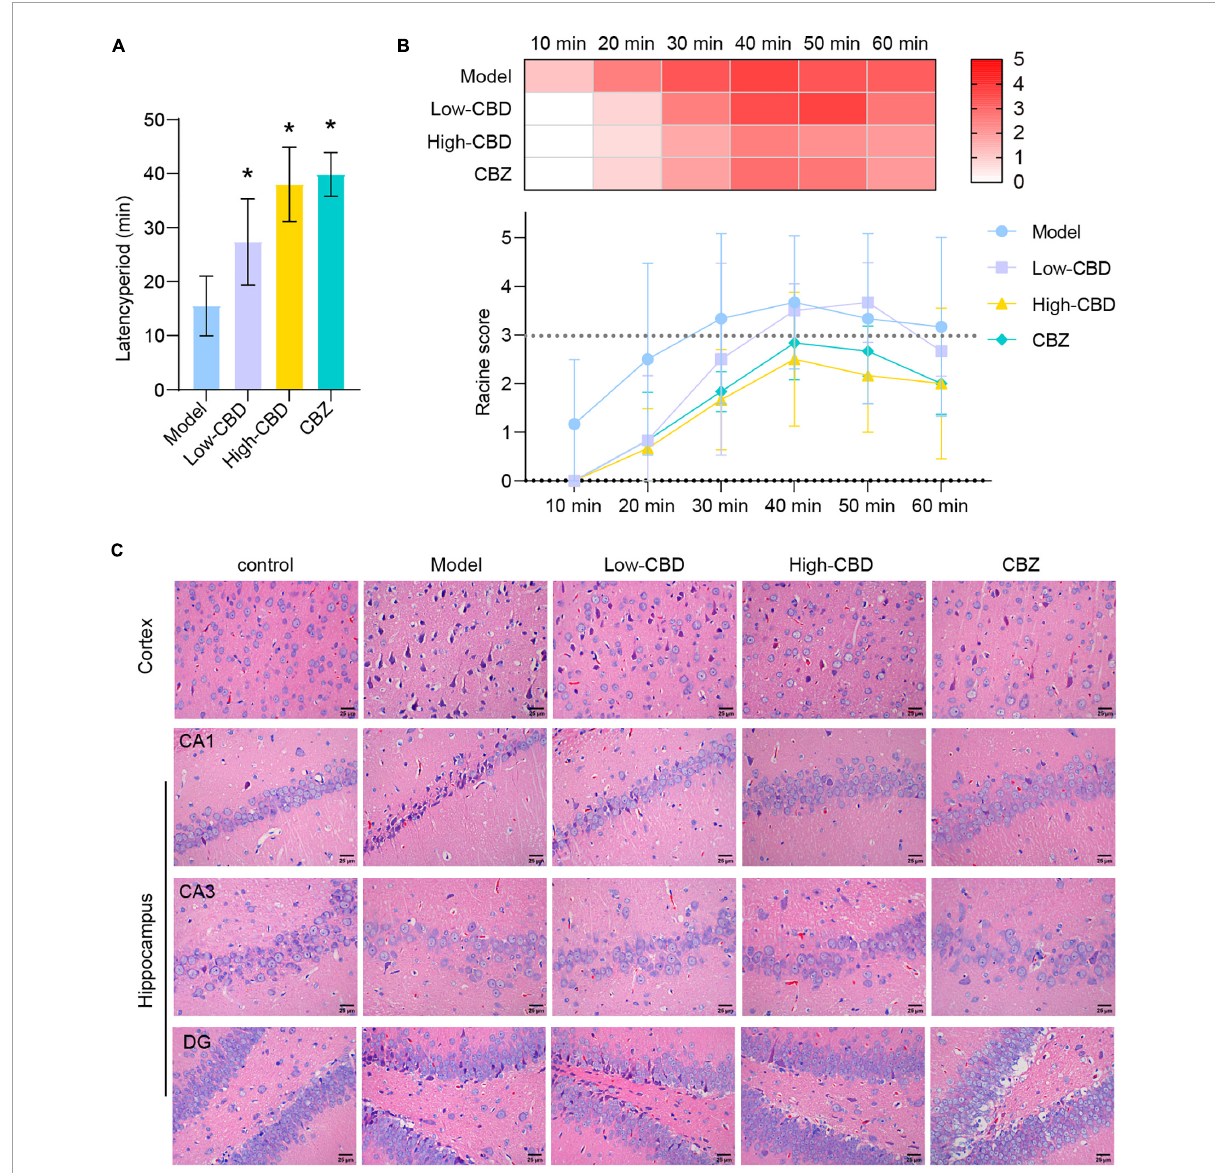
FIGURE1 Cannabidiol (CBD) alleviates Epilepsy in rats. (A) The latency period of epileptic rat. (B) The Racine score within 1 h of modeling. (C) H&E staining results of the temporal lobe cortex and hippocampus. *Represents significant comparison with the Model group, P < 0.05. The darker the red, the higher the Racine